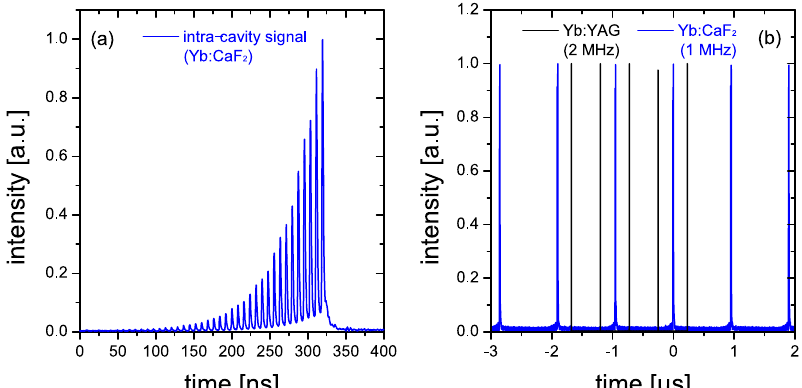
Figure 4. Pulse train measurement: ( a ) intra-cavity signal showing 40 round-trips in the case of Yb:CaF ; ( b ) output signal at 1 MHz for Yb:CaF 2